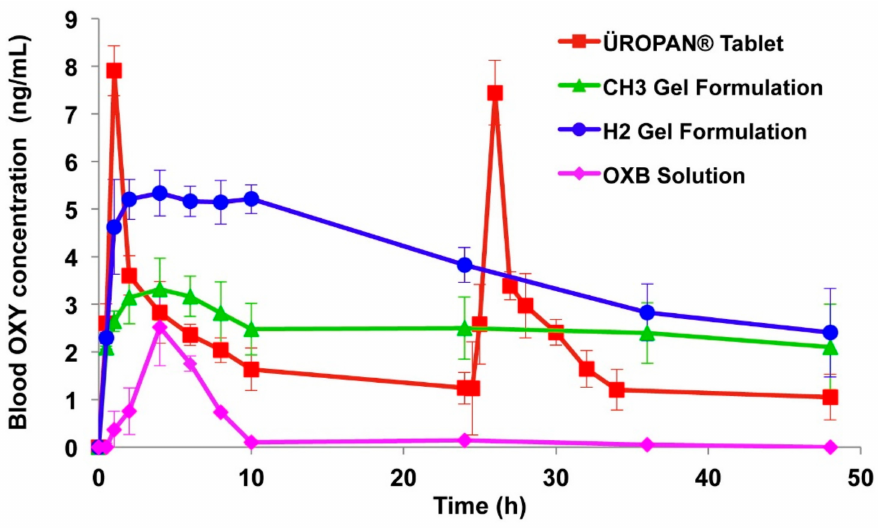
Figure 7. Blood oxybutynin concentration profiles of oral and vaginally administered formulations, CH3 (1% w / v glacial acetic acid and 3% w / v Chitosan H), H2 (2% w / v hypromellose K100M), Reprinted with permission from ref. [58]. Copyright 2013